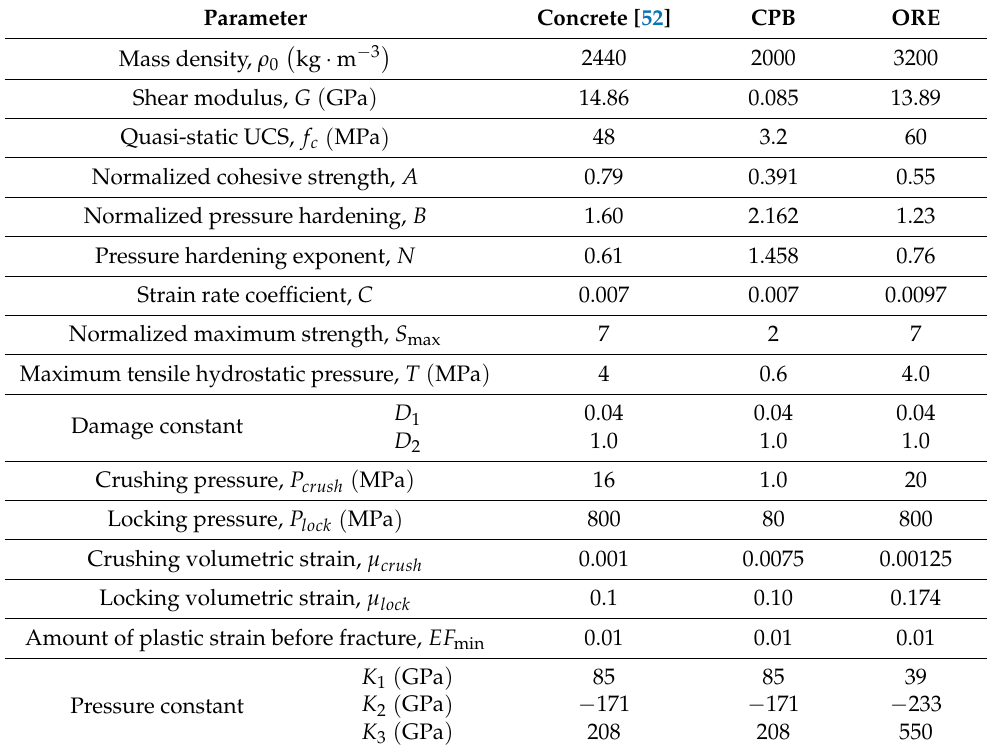
Table 2. Parameters of the HJC materials used in the present work. Parameter Concrete [52] CPB ORE (cid:0) Mass density, ρ 0 kg · m − 3